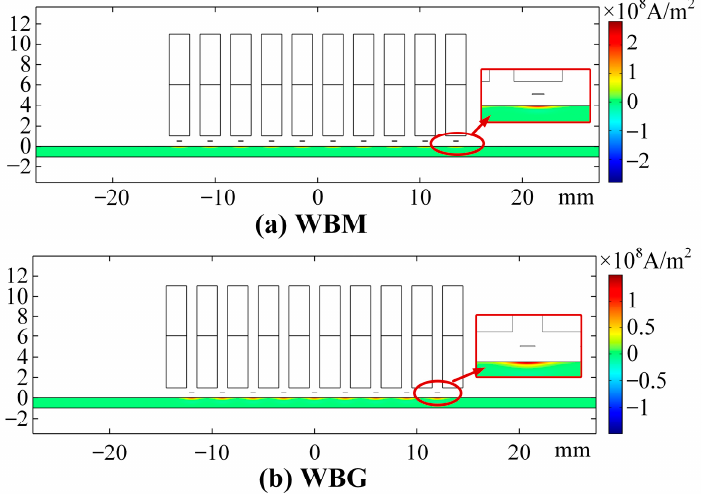
Figure 8. Eddy current density distribution of ( a ) WBM model at 2.922 μ s and ( b ) WBG model at 10.875 μ s.